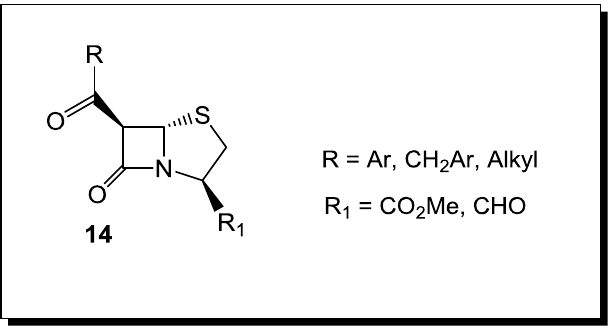
Figure 7. β-Lactams as inhibitors of bacterial pilus